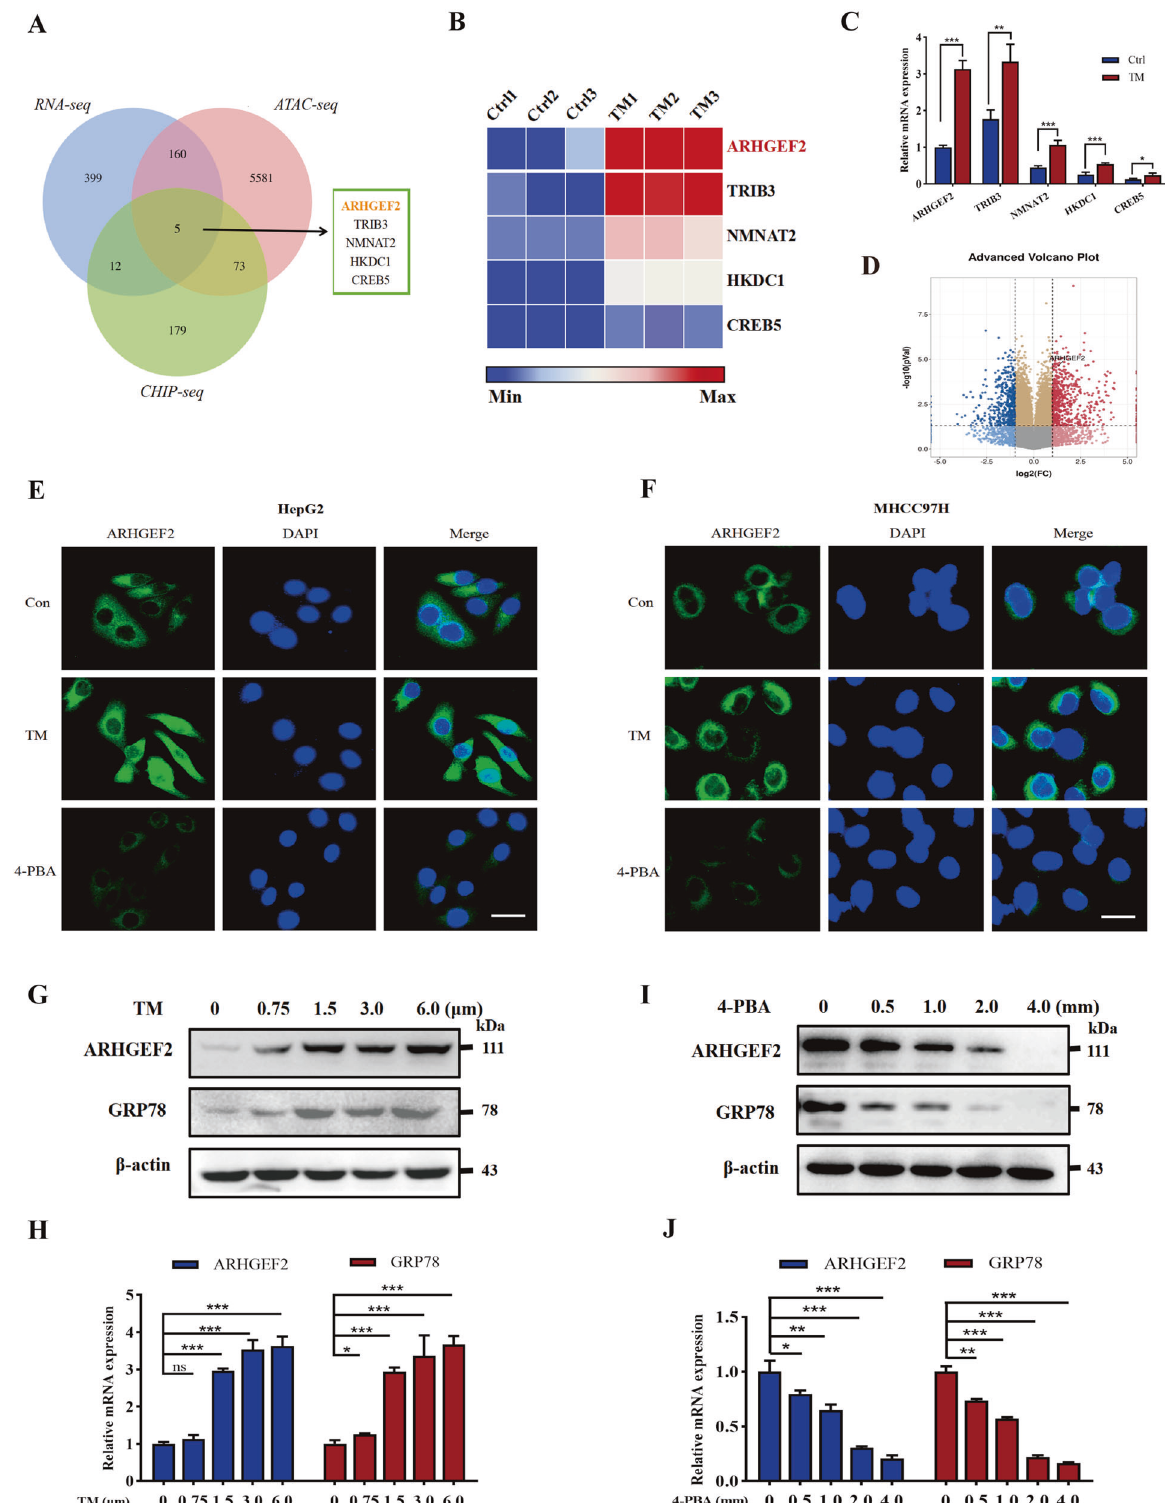
Fig. 1 ER stress upregulated the expression of ARHGEF2 in HCC cells. A RNA-sequencing, ATAC-sequencing, and Chip-sequencing of TM- treated or untreated HepG2 cells were analyzed to fi nd the differentially expressed genes. B A heat map was constructed according to the mRNA sequencing results. C qRT-PCR was used to detect the expression of differential genes in the TM-treated or untreated HepG2 cells. D Volcanic map of the ARHGEF2 expression. E , F HepG2 and MHCC97H cells were treated with TM or 4-PBA, and the expression of ARHGEF2 was detected by immuno fl uorescence. G , H Changes in ARHGEF2 and the GRP78 protein ( G ) and mRNA ( H ) level after the HepG2 cells were treated with different concentrations of TM. I , J After HepG2 was treated with 4-PBA at different concentrations, the protein ( I ) and the mRNA ( J ) level of ARHGEF2 and GRP78 were detected.